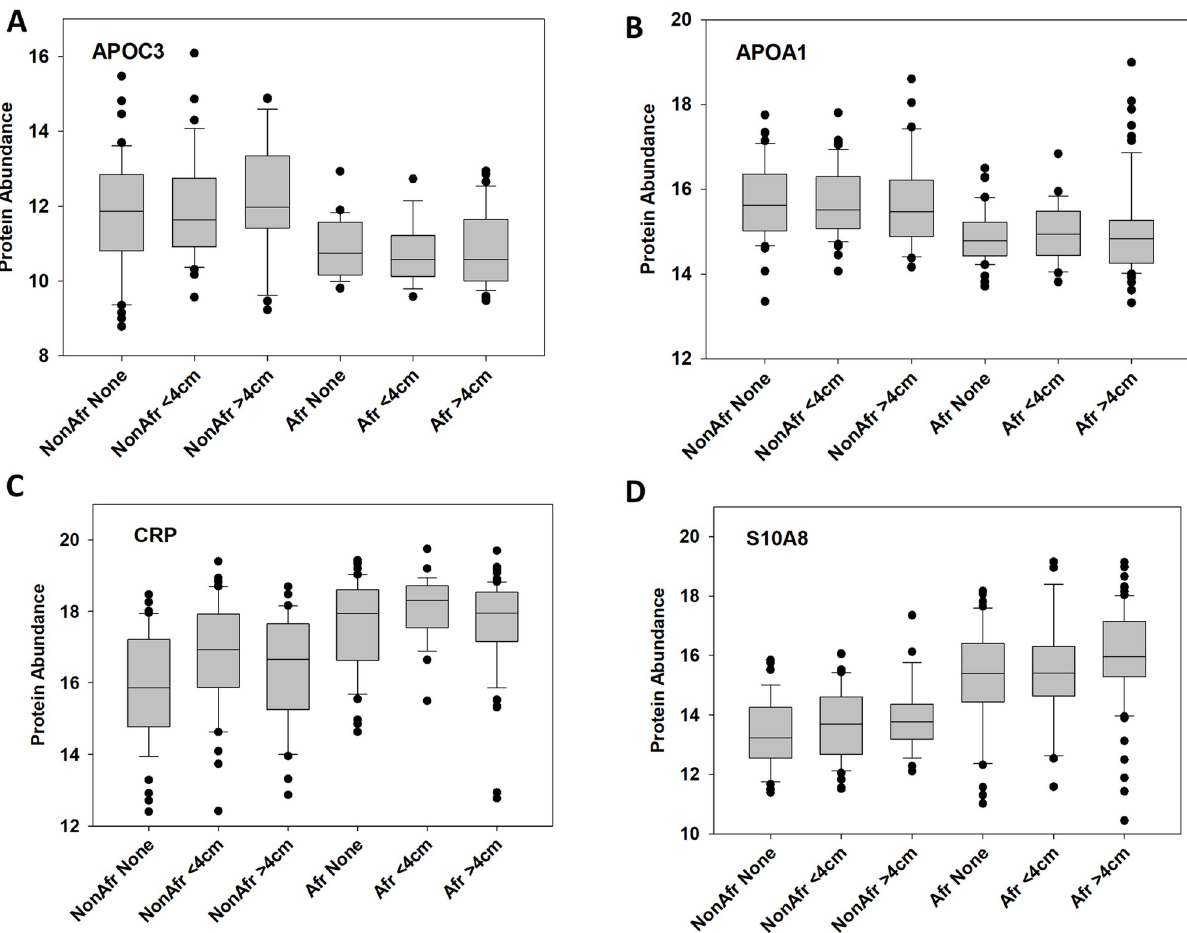
Fig 3. Boxplot of representative proteins across cavitary size. A-D) Boxplot representation of quantitative global MS data from baseline values for two proteins representative of lipid and nutrient transport downregulation within the African cohort and two proteins representing acute inflammatory activation upregulated with the African cohort, all stratified across cavitary size representing initial disease severity.